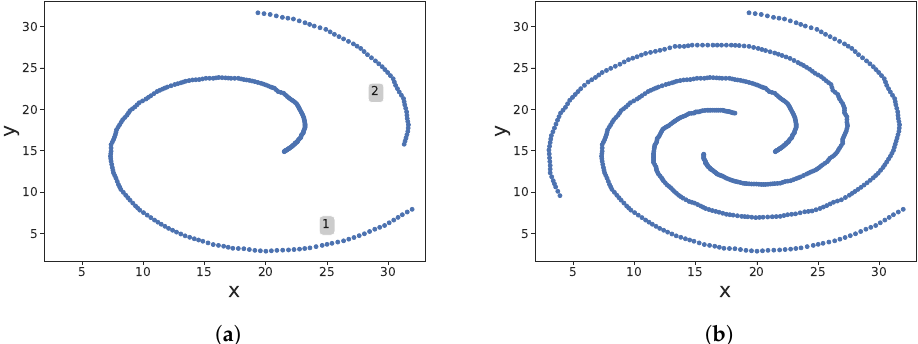
Figure 8. The Three Spirals synthetic dataset. ( a ) The first 261 samples from the Three Spirals dataset. ( b ) The Three Spirals dataset. Table 2. The three sets of synthetic data used. Data Nº of Samples Nº of Clusters Horseshoe 3247 2 T 3744 1 Moon 5000 2 Three Spirals 621